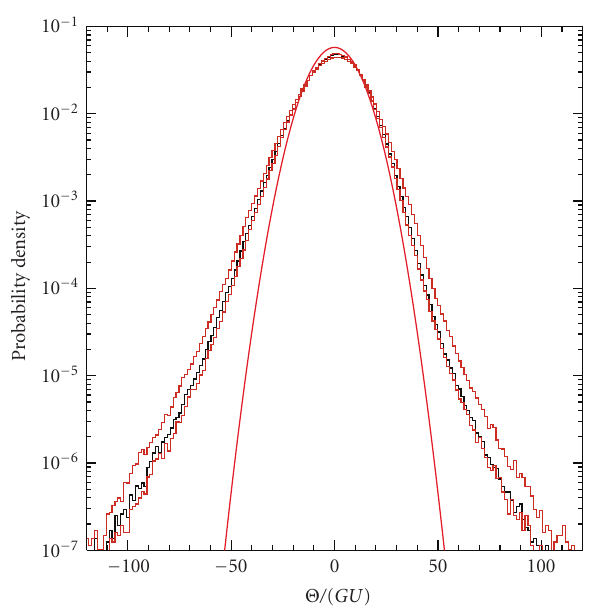
Figure 14: The probability distribution function of CMB tempera- ture fluctuations induced by NG cosmic strings. The orange curves quantify systematic errors coming from the string simulations by including nonscaling loops, or by removing all loops. Deviations from Gaussianity are clearly apparent in the tails of the distribution, as well as from the negative